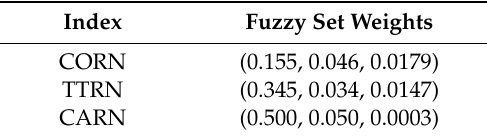
Table 8. Fuzzy set weights of the connectivity reliability of the air traffic network (CORN), TTRN, and CARN.